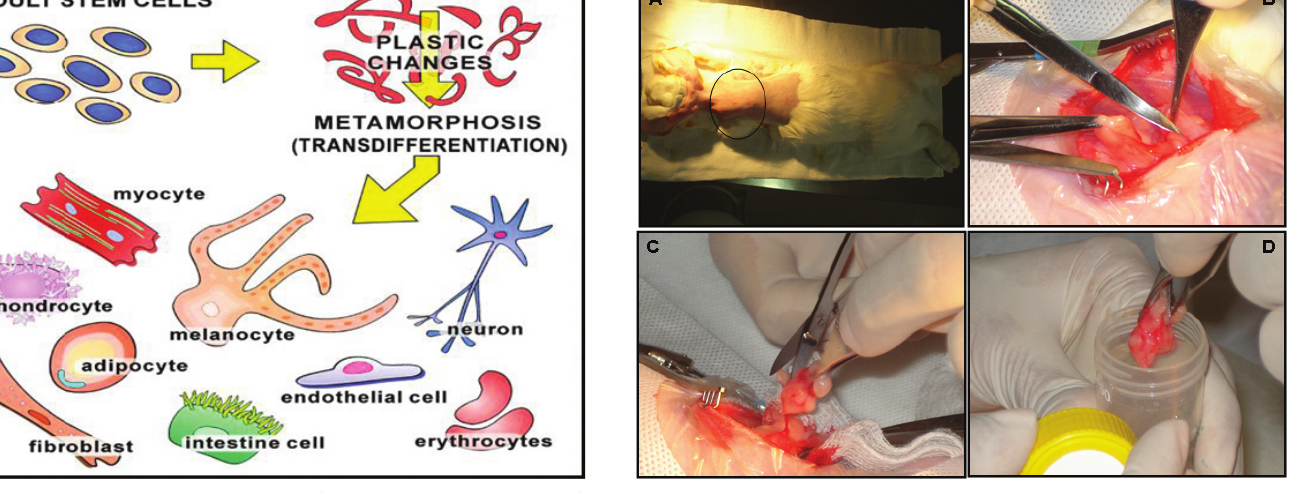
FIGURE 2 - Figures representing. A . dorsal region of rabbit; B . incision of rabbit dorsal region exposing the fat; C . collecting fat from dorsal region; D . Fat on tube with solution of phosphate- buffered saline (PBS)